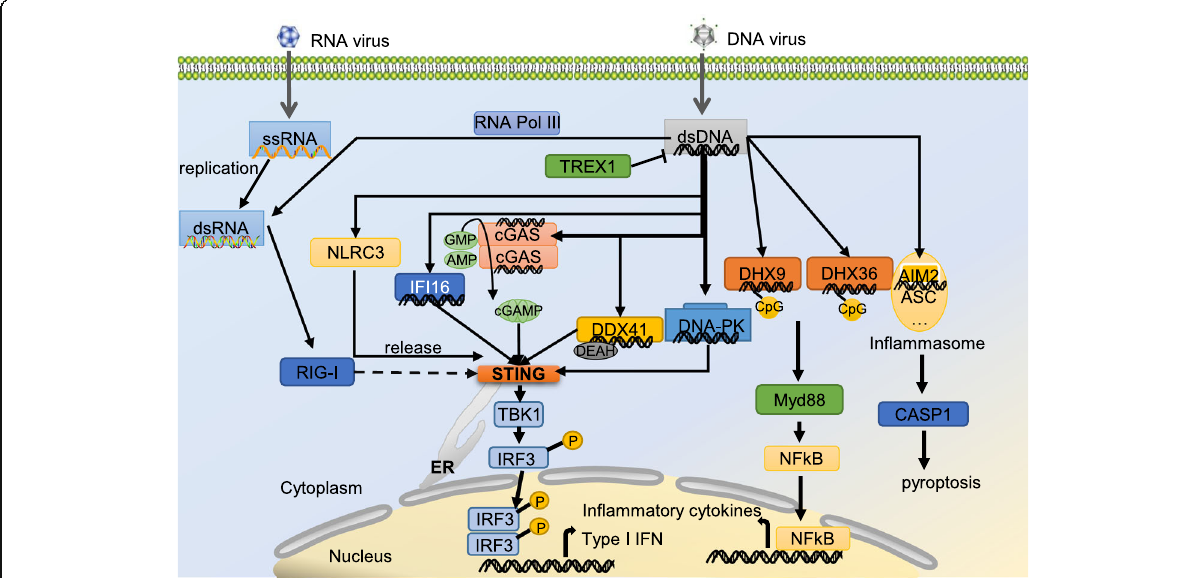
Fig. 2 Cytosolic viral DNA sensing. DNA is a PAMP that can be delivered to the cytoplasm of host cells during microbial infection. Several DNA sensors have been reported to promote the activation of innate immune signaling by activating a STING-dependent signaling pathway. Among them, cGAS can catalyze ATP and GTP to generate the second messenger cyclic GMP-AMP (cGAMP) and then activate STING. However, the molecular basis by which other DNA sensors activate STING is not well understood. RNA polymerase III can activate the immune response in a STING-independent way, RNA polymerase III can transcribe poly (dA-dT) into dsRNA, which is then recognized by RIG-I. Several members of DExD/H helicases are also respond to cytosolic dsDNA, such as DHX9, DHX36 and DDX41. In IRF3-mediated innate immune responses of fibroblasts, DNA-PK recognizes cytoplasmic dsDNA of vaccinia virus. TREX1 is well known to protect host from excessive inflammation via efficiently degrading cytosolic endogenous DNA. PYHIN family proteins: AIM2 and IFI16. AIM2 senses dsDNA from virus and oligomerizes to form AIM2 inflammasome. IFI16 binds to cytoplasmic viral DNA and mediates the activation of STING-TBK1-IRF3 axis. Moreover, NLRC3 recognizes dsDNA and releases STING, which activates type I interferon